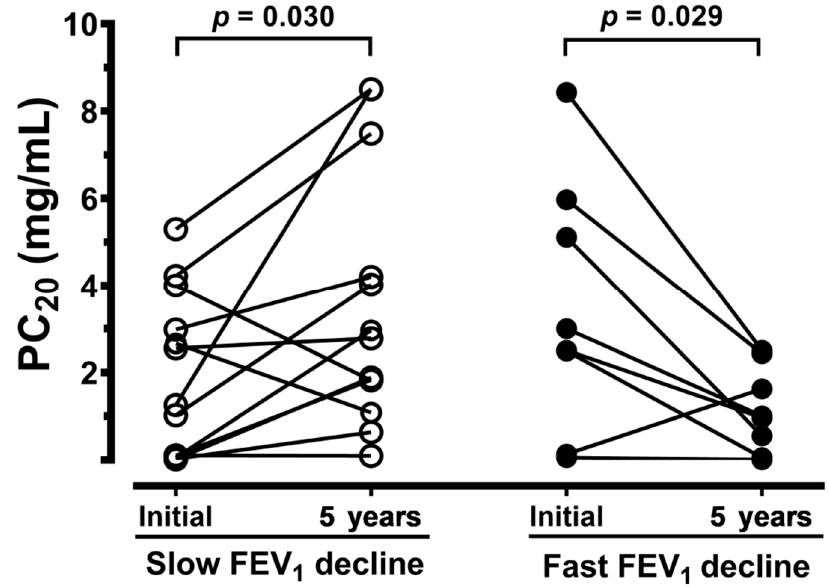
Figure 3. The individual concentration of methacholine provocation in asthmatic patients who had a slow FEV 1 decline (open circle, n = 13) or a fast FEV 1 decline (solid circle, n = 8) after receiving 5 years of inhaled anti-asthma medicine, compared with the initial values (initial). The significance is